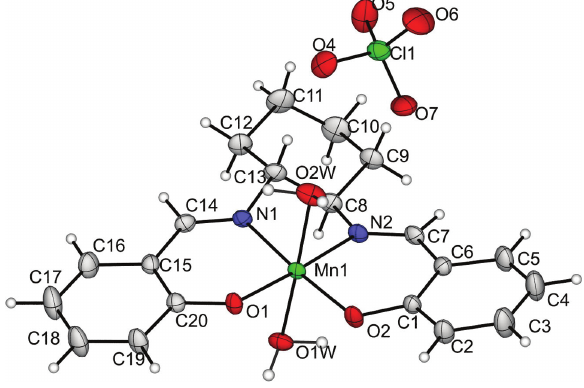
Table 2: Fractional atomic coordinates and isotropic or equivalent isotropic displacement parameters (Å 2